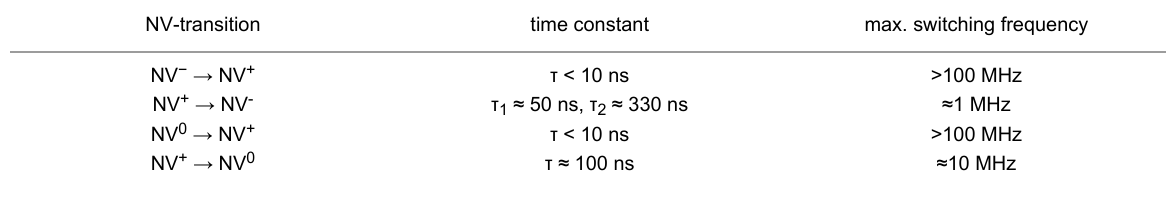
Table 1: Summary of measured switching speed. Measured time constants for switching a single NV centre between the fluorescent and non-fluores- cent states as well as the corresponding calculated maximum (theoretical) switching